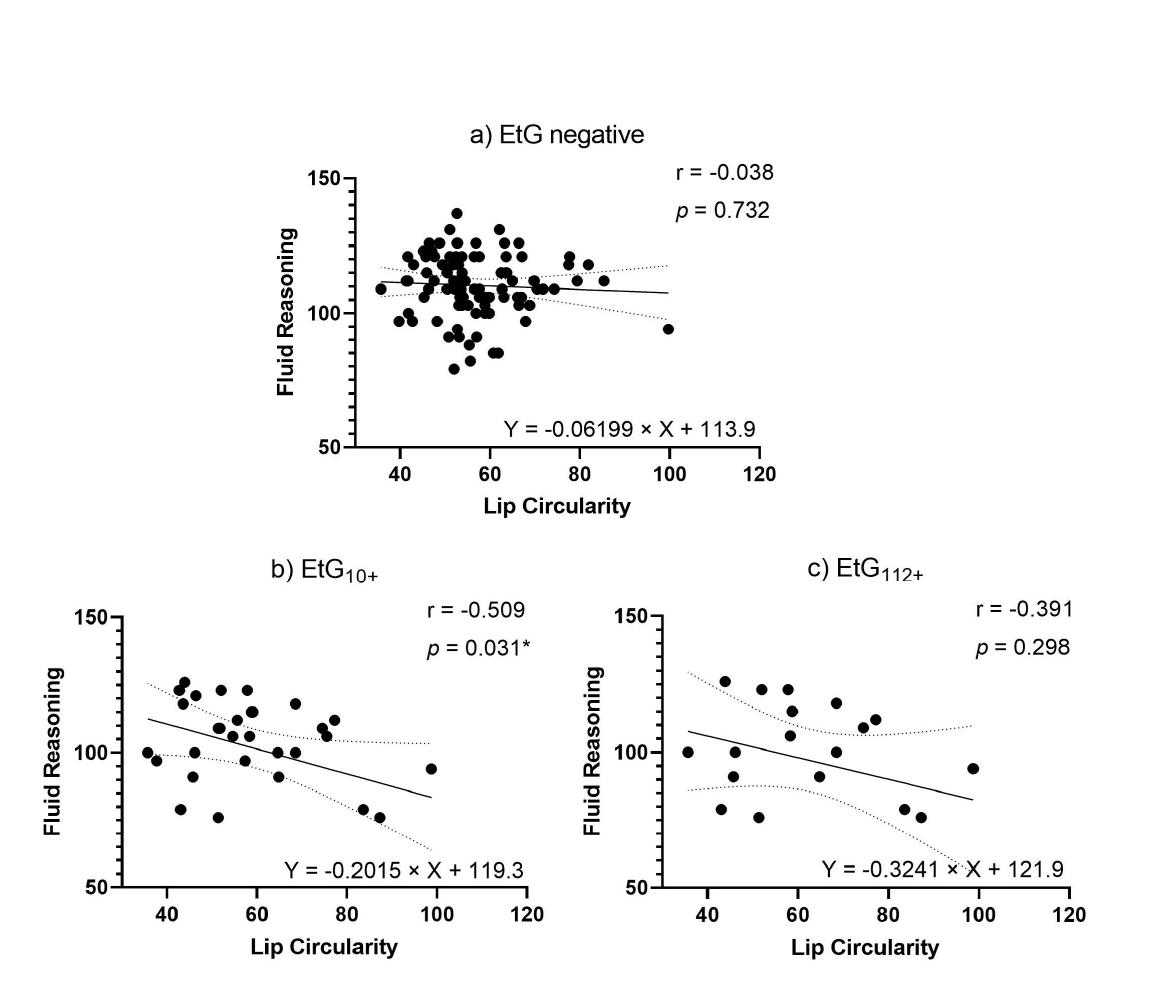
Figure 4. ( a ) Lip circularity versus fluid reasoning for EtG-negative individuals (10 ng/g cut-off, EtG-negative n = 97). ( b ) Lip circularity versus fluid reasoning for EtG10+ individuals (EtG 10 + n = 32). ( c ) Lip circularity versus fluid reasoning for the EtG112+ (EtG 112 + n = 20) cut-off. Higher lip circularity value = smaller upper lip size. * p <